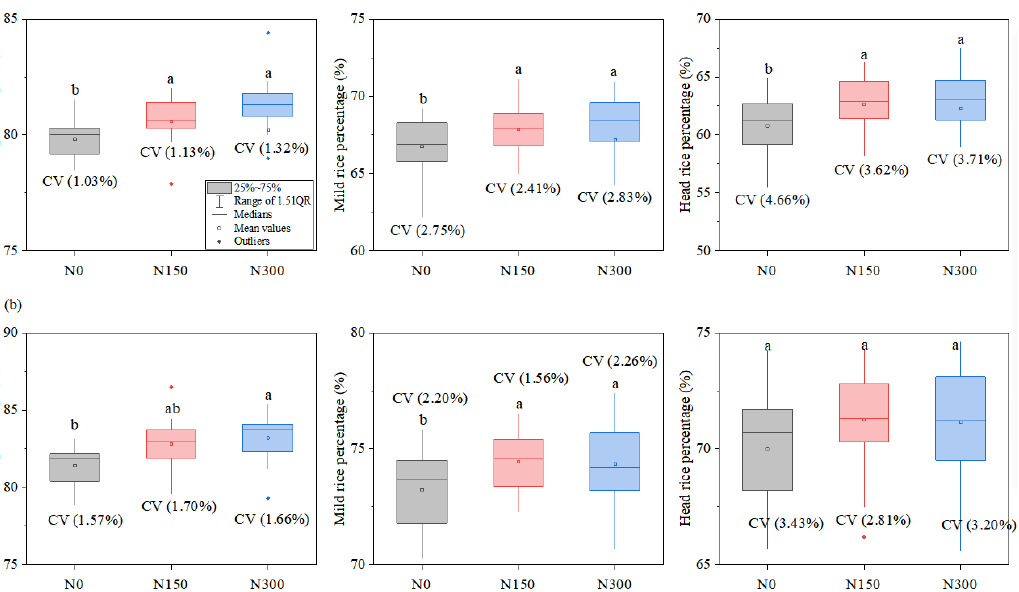
Figure 2. Distribution chart of milling quality for hybrid indica rice varieties ( a ) and inbred japonica rice varieties ( b ) with different nitrogen levels. The values of different lowercase letters refer to significant differences at p < 0.05 among different nitrogen levels. The CV value refers to the coefficient of variation. N0, N150, and N300 refer to treatments with 0 kg ha − 1 , 150 kg ha − 1 , and 300 kg ha − 1 applied.